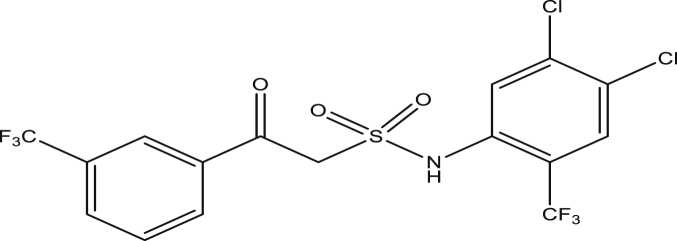
Compound 9d [N-(4,5-dichloro-2-(trifluoromethyl)phenyl)-2-oxo-2-(3-(trifluoromethyl)phenyl)ethanesulfonamide (pEC500.4080003)].